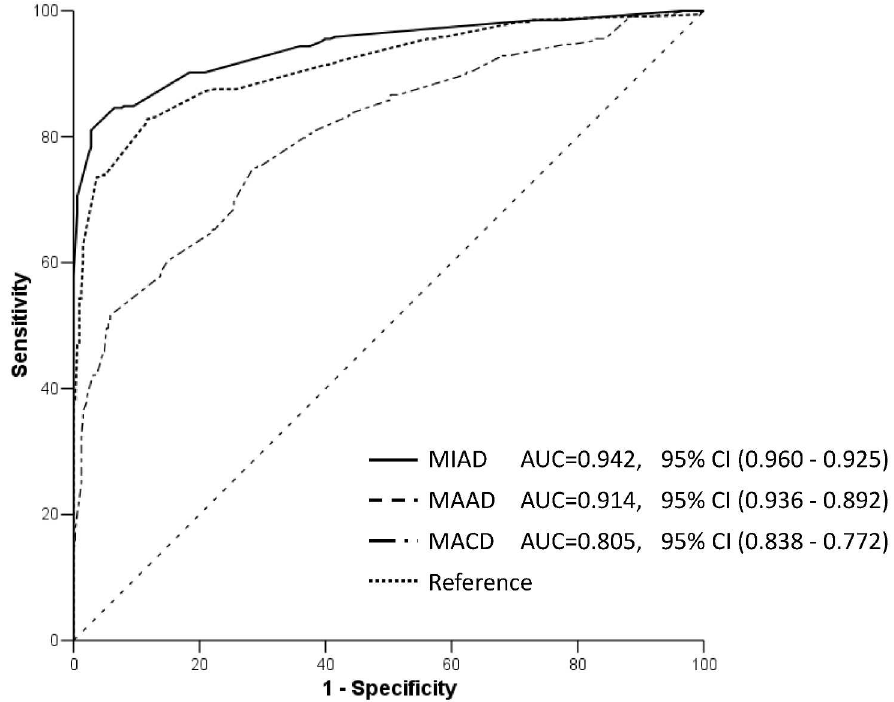
Fig 4. ROC curves of parameters in stage I. Receiver operating characteristic curves of the three nodal diameters: minimal axial diameter (MIAD), maximal axial diameter (MAAD), and maximal coronal diameter (MACD). The MACD is a much less valid criterion because the area under the curve is obviouslylower than that of the other two diameters (without any 95% confidenceinterval overlapping of its area under curve to that of MIAD and